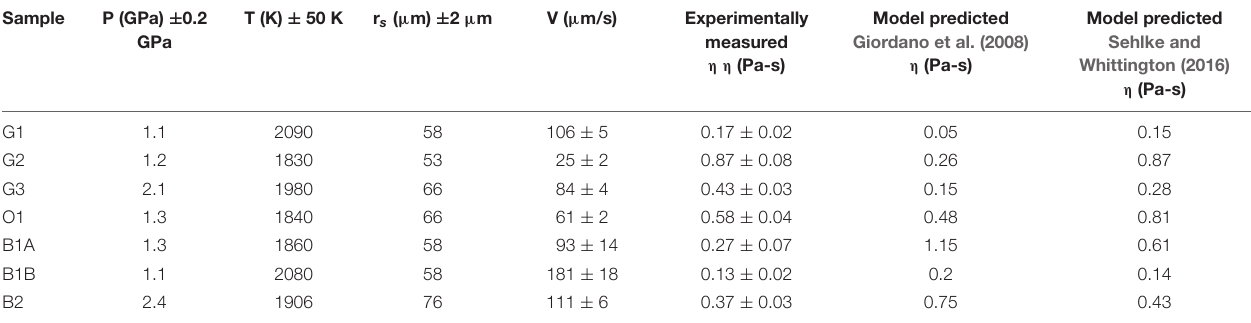
TABLE 2 | Experimental run conditions, measured viscosities and